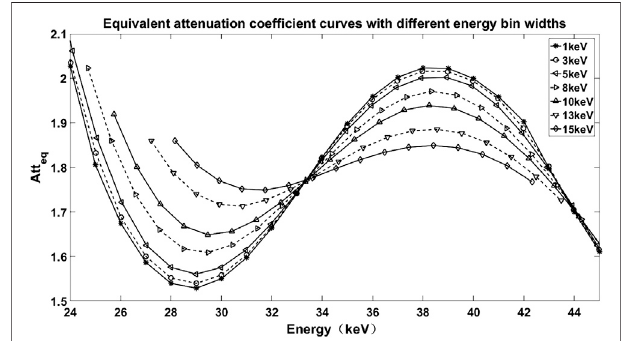
FIGURE3| Equivalentmassattenuationcoef fi cient curvesofiodinewith different energy bin